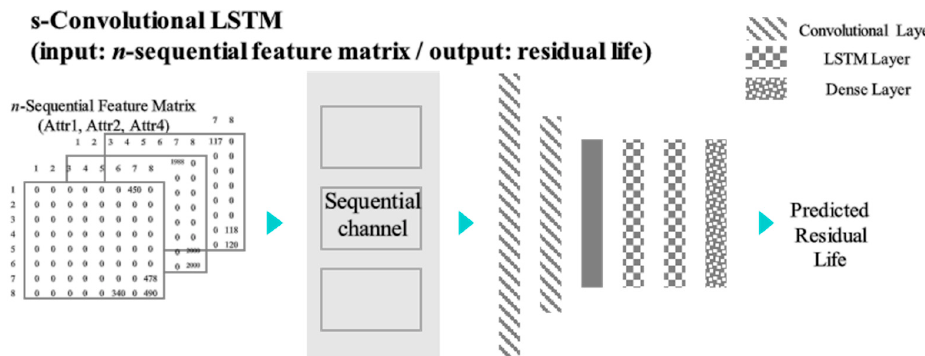
Figure 8. Proposed model configuration and I/O.